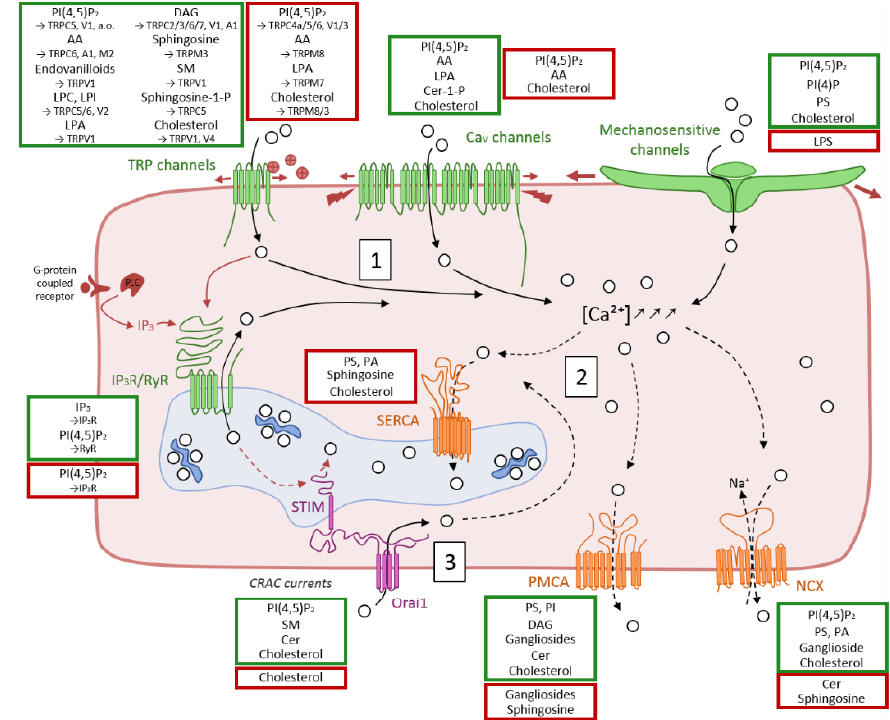
Figure 5. Main Ca 2 + transport proteins and their known regulation by lipids. ( 1 ) Following a diversity of stimuli (in brick red), Ca 2 + (white dots) influx into the cytosol will occur through channels at the plasma membrane (PM) or at the endo- / sarcoplasmic reticulum (ER / SR) membrane (in green). ( 2 ) Ca 2 + increase will activate transport proteins (in orange) that export Ca 2 + out of the cell or inside the ER / SR (in light blue), where it is sequestrated by calreticulin / calsequestrin (in blue). ( 3 ) Store-Operated Ca 2 + Release-Activated Ca 2 + (CRAC) currents (in pink) occur through the PM upon depletion of the ER / SR Ca 2 + stores. Continuous and discontinuous arrows point to cytosolic Ca 2 + increase and decrease, respectively. All Ca 2 + transport proteins are represented based on their known structure (see description in the sections below), except for the Piezo mechanosensitive channel, for which a simplified view of the trimer is shown. For inositol-3-phosphate receptor (IP 3 R) and ryanodine-receptor (RyR) tetramers and Orai1 hexamer, only one monomer is represented, while for Ca v channels only the α -subunit is drawn. Regarding regulation of those Ca 2 + transport proteins, only lipids are depicted: Those stimulating the transport proteins are boxed in green and those inhibiting them are in red.